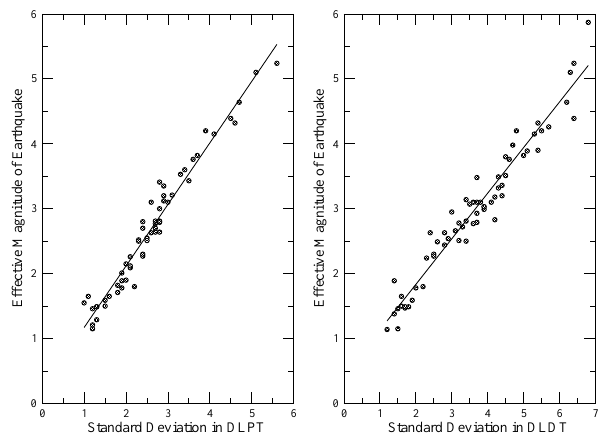
Fig. 9. Effective magnitudes of the earthquakes as a function of the deviations from the mean of DLPT (left) and DLDT (right). The correlation is generally linear, i.e., the effective magnitude or the energy deposited of the associated earthquake is directly related to the observed